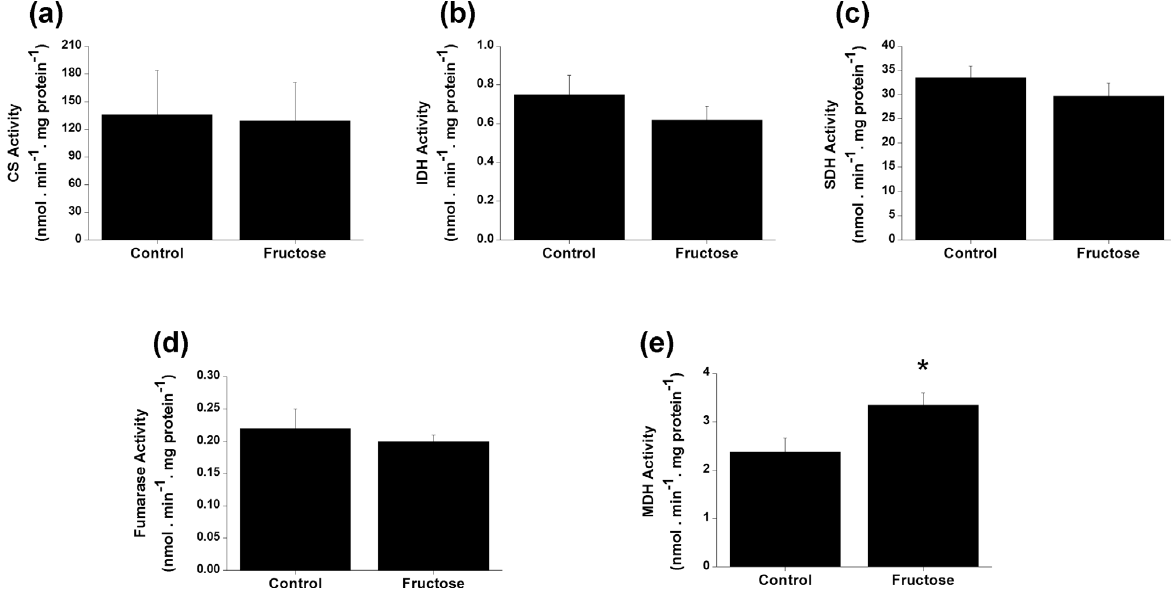
Figure 1 - Effects of acute fructose administration on the activities of Krebs cycle enzymes citrate synthase (CS) ( a ) , isocitrate dehydrogenase (IDH) ( b ) , succinate dehydrogenase (SDH) ( c ), fumarase ( d ) , and malate dehydrogenase (MDH) ( e ) in rat cerebral cortex of rats 24 h after the administration. Values are means ± standard deviation for five to six independent experiments per group performed in duplicate and are expressed as nmol . min -1 . mg protein -1 . * p < 0.05 compared to controls (Student’s t test).